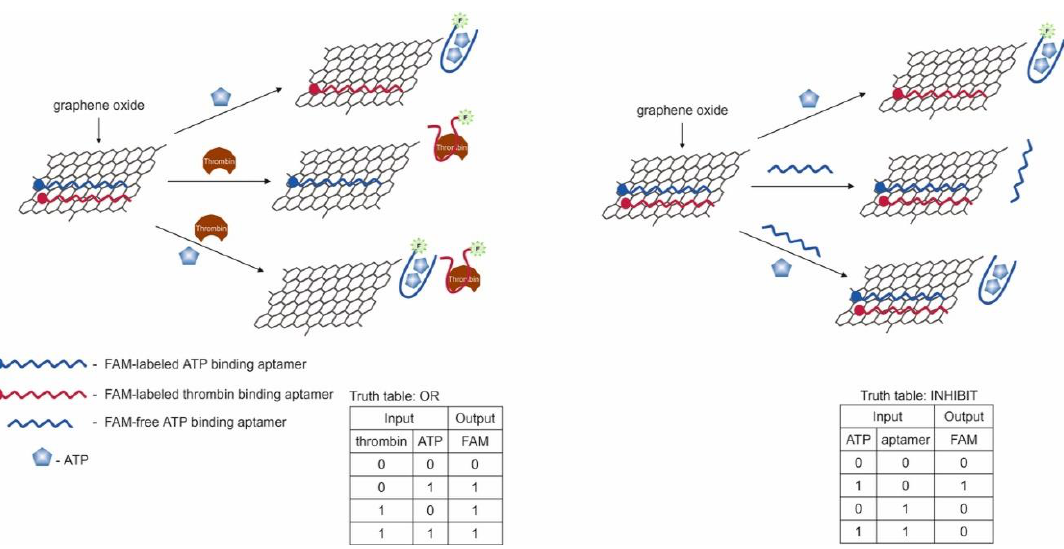
Figure 9. Logic gates OR and INHIBIT. Adapted from Reference [76]. ATP = adenosine triphosphate. Copyright © 2020 American Chemical Society.